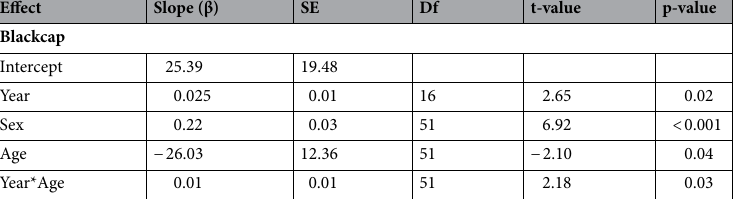
Table 2. Summary of model testing trend in the blackcap wing length. Results of linear mixed-effect model testing the effect of Year, Age and Sex (with Year also as random effect) on the average wing length of blackcap captured during spring migration in Jerusalem, Israel during the study period